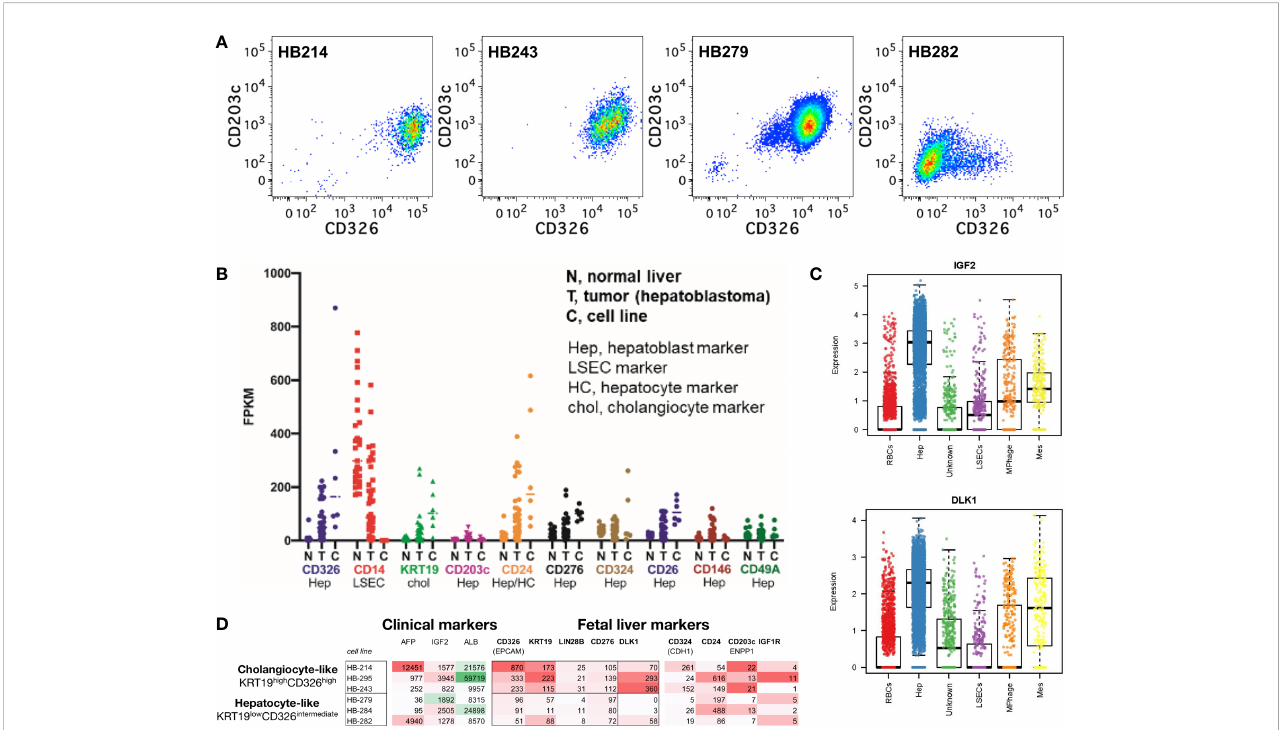
FIGURE 8 Hepatoblastoma phenocopies fetal hepatoblasts and cholangiocytes including a CD203c phenocopy. (A) Expression of CD326 and CD203c in hepatoblastoma cell lines. (B) Hepatoblastoma tumor biopsies and hepatoblastoma cell lines have reduced or absent LSEC markers ( e.g. , CD14), bimodal cholangiocyte markers ( e.g. , KRT19 ) and mixed/bimodal hepatoblast markers (CD326, CD24, CD324 and CD26). (C) Single cell sequencing of fetal liver hepatoblasts reveals cell-type selective enrichment of IGF2 and DLK1 , which are feasible therapeutic targets, as well as AFP (a known hepatoblastoma marker) in FPKM. (D) Upon closer examination of known hepatoblast markers, two phenotypes of hepatoblastoma cell lines are observed: cholangiocyte- precursor-like and